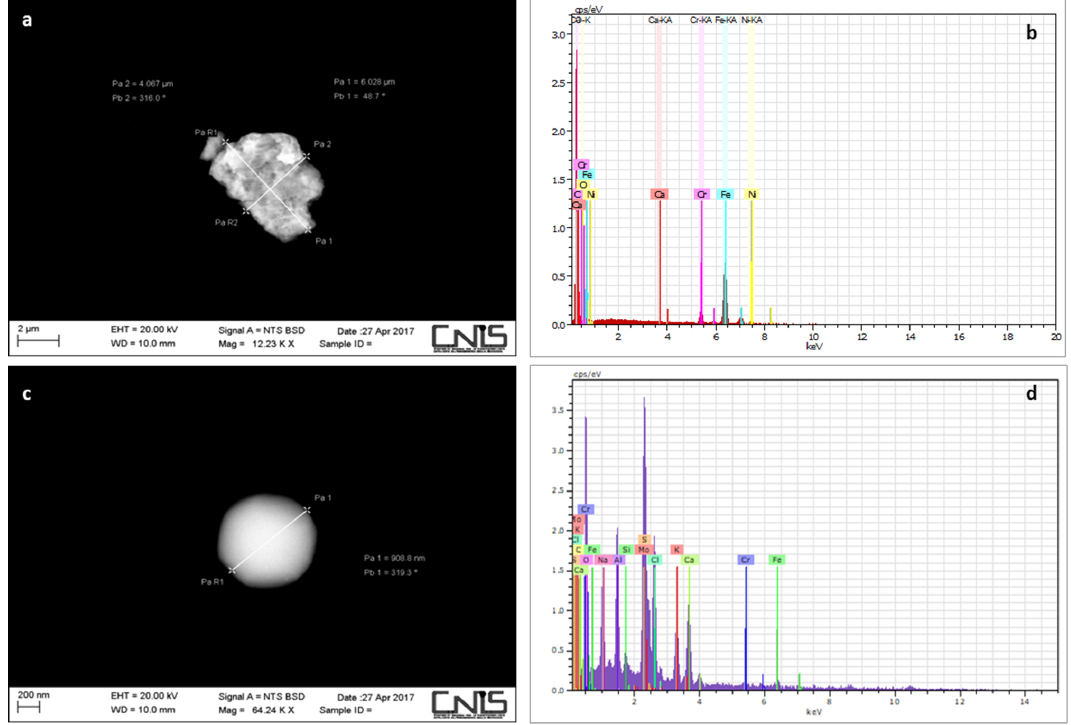
Figure 4. SEM micrograph ( a ) and respective EDX spectrum ( b ) of a steel particle (Cr, Fe, and Ni) sampled near the steel plant. SEM micrograph ( c ) and respective EDX spectrum ( d ) of a Mo particle sampled near the steel plant.